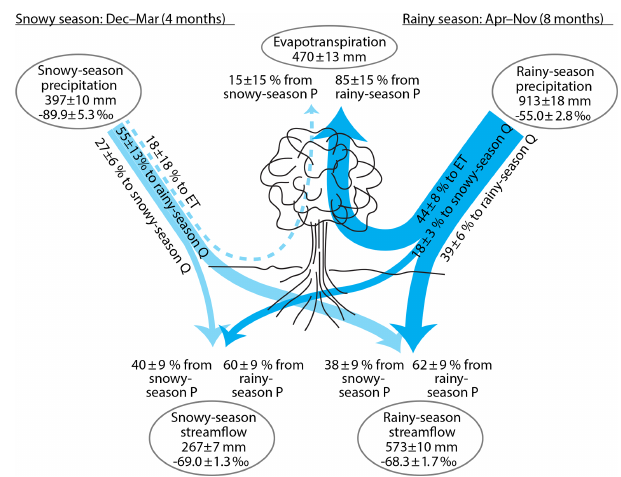
Figure 4. Partitioning of precipitation (P) into streamflow (Q) and evapotranspiration (ET) during the snow-dominated sea- son (December–March) and the rain-dominated season (April– November), inferred from annual water fluxes and volume- weighted δ 2 H at Hubbard Brook Watershed 3. Essentially all evap- otranspiration is derived from rainy-season precipitation. Roughly half of rainy-season precipitation eventually evapotranspires, about one-third eventually becomes rainy-season streamflow, and about one-sixth eventually becomes snowy-season streamflow. Only about one-fourth of snowy-season precipitation becomes snowy- season streamflow, with about half becoming rainy-season stream- flow and perhaps one-fifth being lost to evaporation and tran- spiration. Roughly half of each season’s streamflow is derived from the other season’s precipitation, implying substantial inter- seasonal storage in snowpacks or groundwaters. All quantities are shown ± standard errors. Widths of lines are approximately propor- tional to water fluxes. Fluxes within 1 standard error of zero are shown by dashed lines. Percentages may not add up to 100 due to